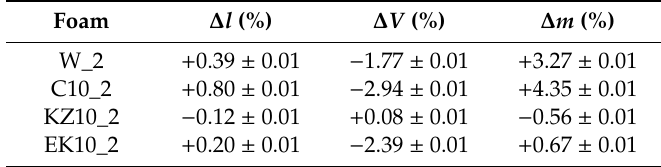
Table 4. Results of foam aging measurement in an air dryer (120 °C, 48 h).